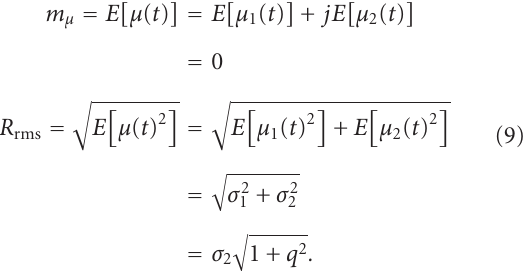
Figure 1: Von Mises PDF showing nonisotropic